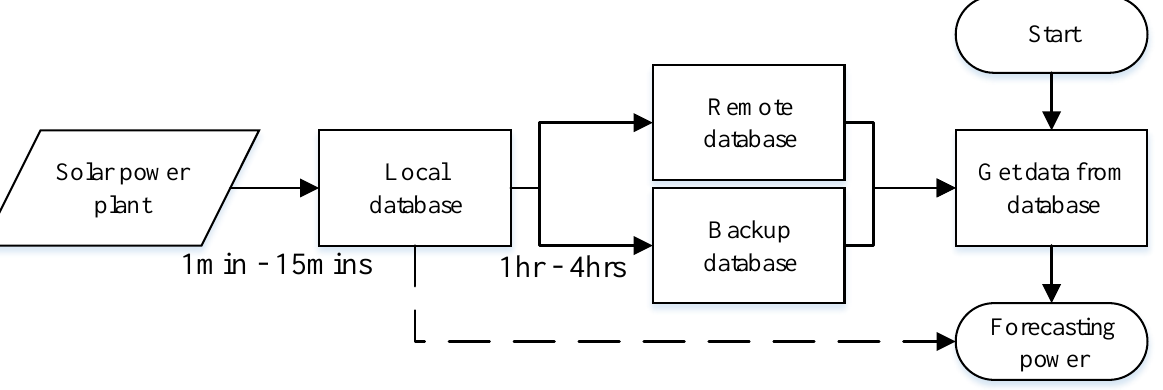
Figure 2. Schematic diagram of information acquisition process by solar PV power operator in Taiwan.